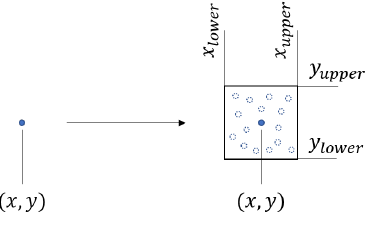
Figure 1. Visualisation of the abstraction of a single data-point to a set of points, representing a hypercube. The solid point represents the concrete point, and the dotted ones represent points that are now also considered using the